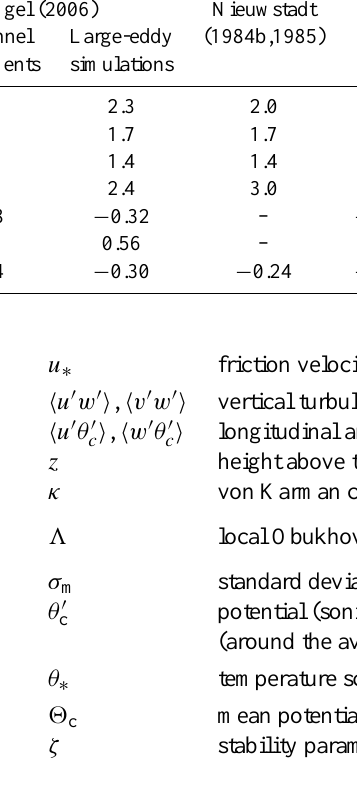
In this paper, the subscript “ L ” on the turbulence